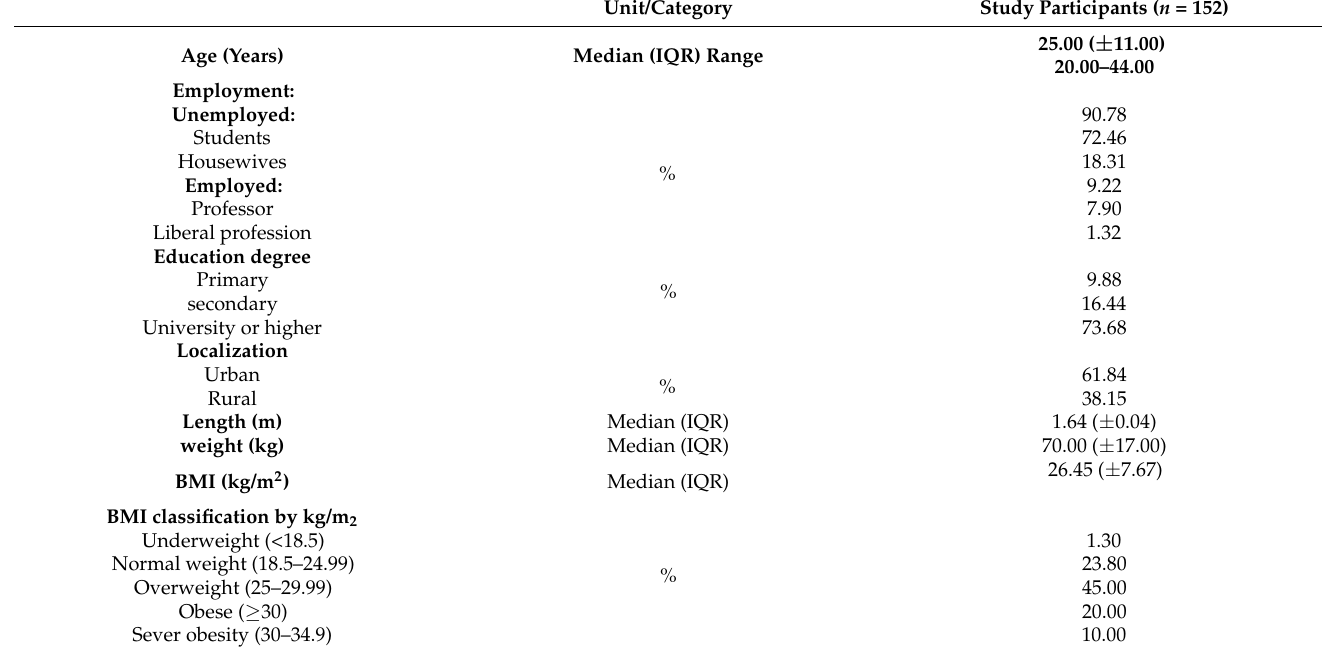
Table 2. Descriptive characteristics of study participants ( n = 152).